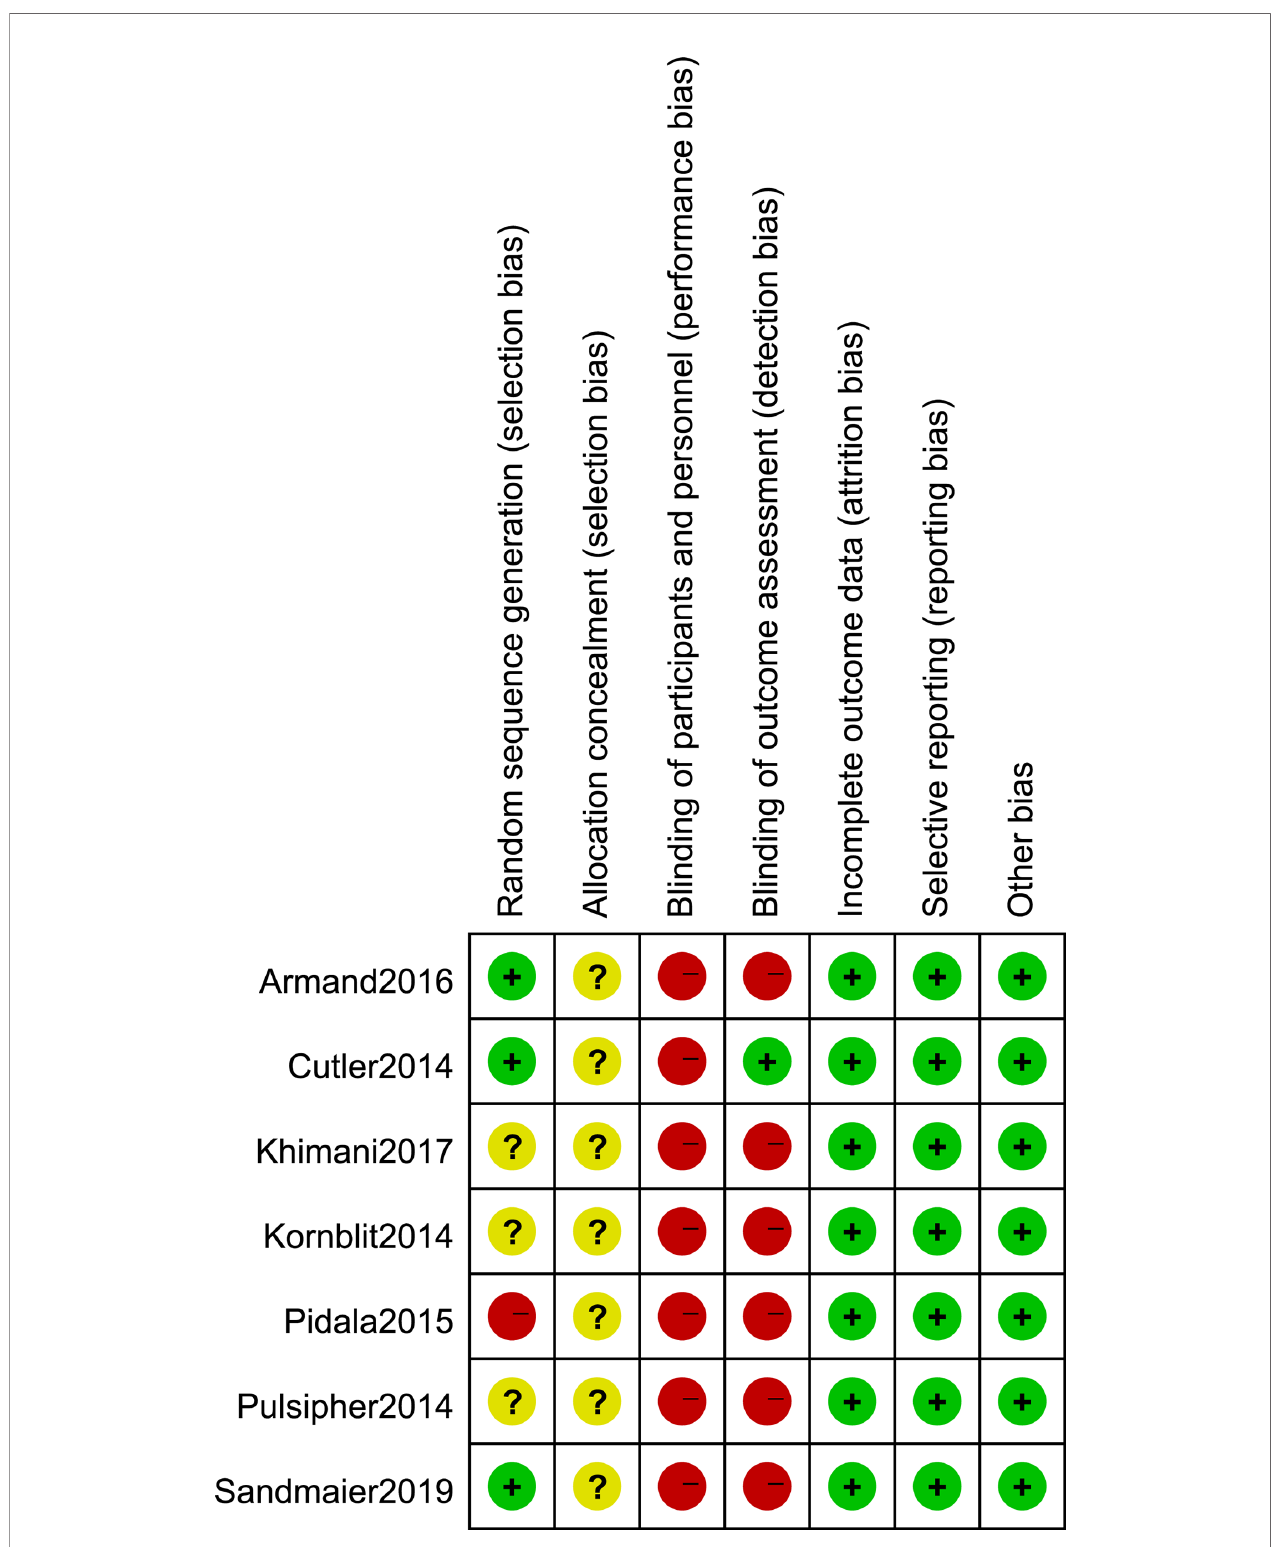
FIGURE 2 | Risk of bias of included randomized controlled